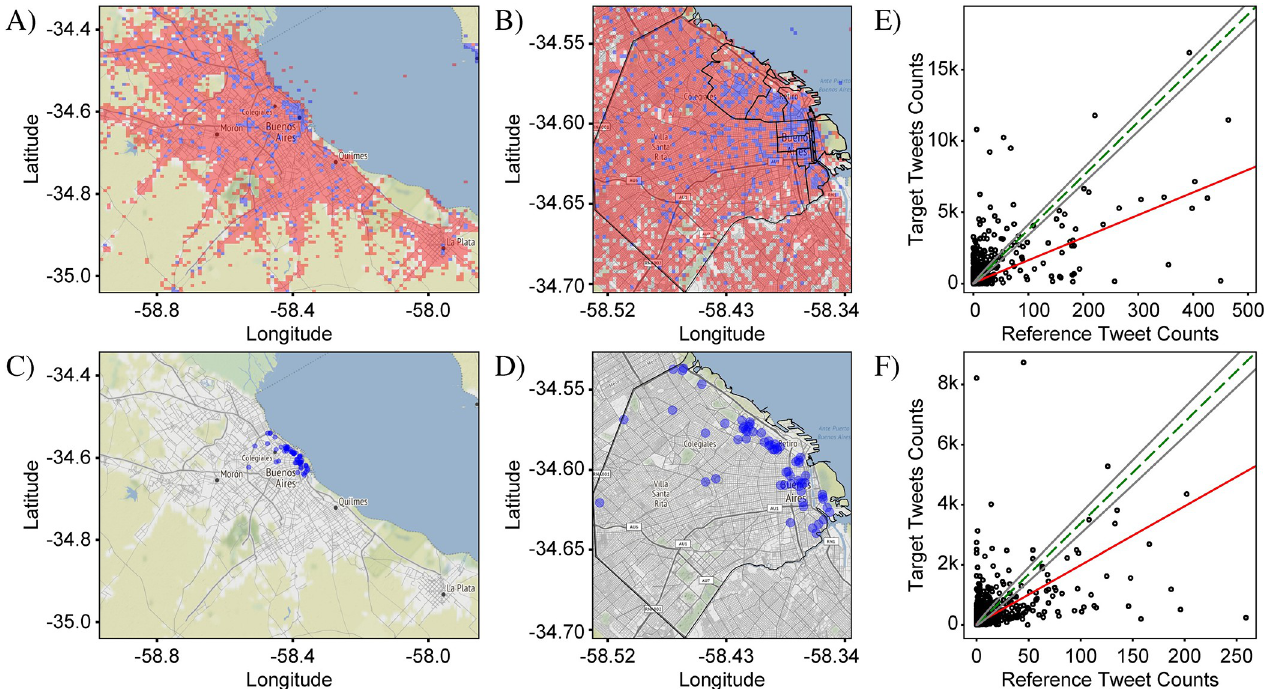
Fig 10. Analysis of local vs. foreign users. (A) & (B) Differential distributions of local vs. foreign users over CABA+ and CABA extents, respectively. Blue (red) indicates where foreign (local) users tweet more prominently. The graph in (A) shows that foreign users are much more strongly represented within the city than in the surrounding area, while the graph in (B) shows that they are mostly localized to the eastern and north-eastern part of the city along the coast in the neighborhoods of Palermo, Recolleta, Retiro, San Nicola´s, Monserrat, Puerto Madero, San Telmo and La Boca, outlined in black. (C) & (D) Maps of the locations of monuments, museums and other attractions extracted from Google Maps, plotted over the extents of CABA+ and CABA, respectively. The pattern of these attractions matches very well with the pattern of tweeting by foreign users both on the extents of CABA+ and CABA, indicating tourism as a strong candidate as a driver of the pattern. The highest concentration of blue bins is in the area of the Central Business District, identified in Fig 8B, which is known as the cultural and business center of Buenos Aires [42], indicating business as another potential driver. (E) & (F) Frequency comparison plots for CABA+ and CABA, respectively. The plots show a wide dispersion of points around the exact-correlation line, indicating the presence of moderately strong signal. The dispersion appears slightly greater in the CABA+ than in the CABA data, which agrees with CABA+ having a stronger signal, as measured by both the Pearson correlation and Kolmogorov-Smirnov statistic-based metrics. CABA+ Statistics: N T = 764,661, N R = 20,237, S PCC = 0.22, KSS = 0.17, GMI = 0.11 CABA Statistics: N T = 442,638, N R = 13,106, S PCC = 0.07 KSS = 0.11, GMI = 0.04. Base map and data from OpenStreetMap and OpenStreetMap Foundation under the Open Database License (Fig